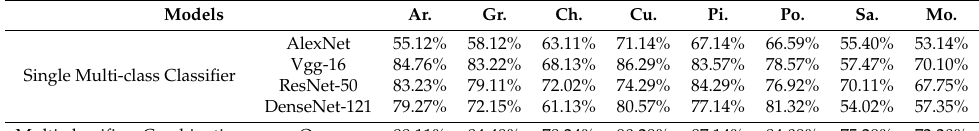
Table 6. The comparison results between single multi-class classifier and multi-classifiers combination (Species abbreviations are composed of the first two letters from each type of allergic pollen).